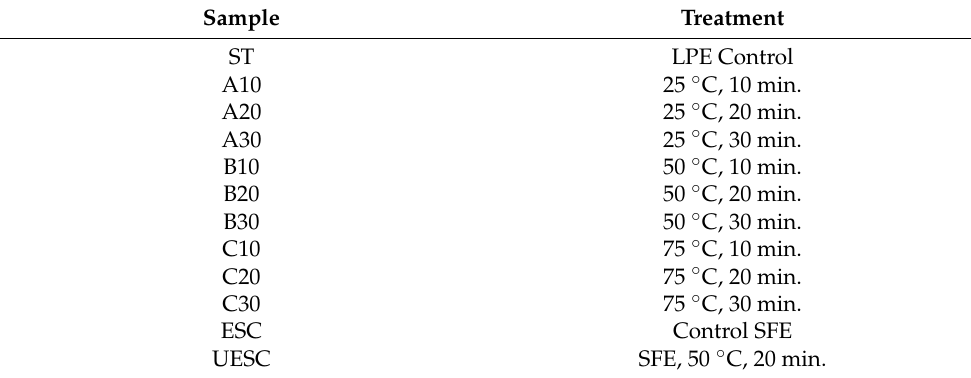
Table 2. Pretreatment conditions for each green propolis extract obtained by ethanol (EtOH) (LPE) and supercritical (SCO 2 ) extraction